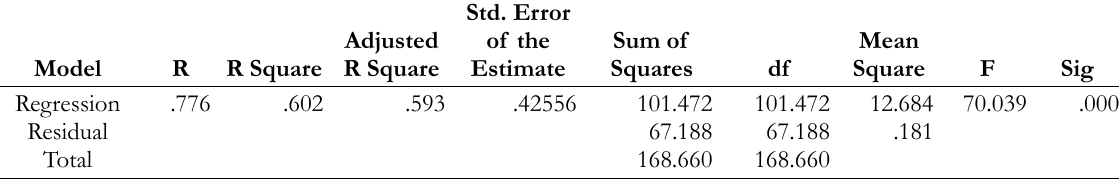
Table 6. Model summary